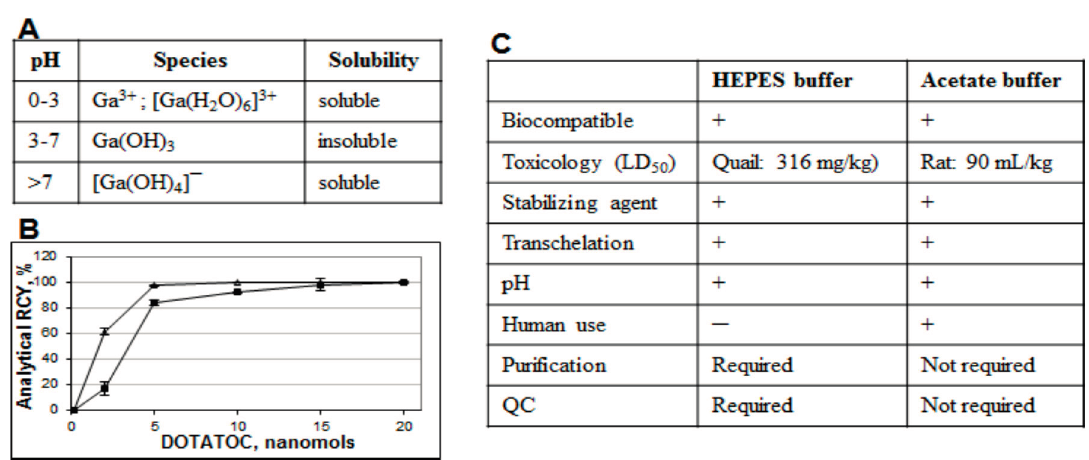
Figure 10. ( A ) Table showing formation of various species dependent on pH; ( B ) Influence of the buffering system ( ■ sodium acetate, ∆ HEPES) on the 68 Ga radioactivity incorporation for different DOTA-TOC quantities (1 min microwave heating at 90 ± 5 °C). The reaction was conducted using the 1 mL peak fraction of the original generator eluate; ( C ) Table comparing characteristics of acetate and HEPES buffers.